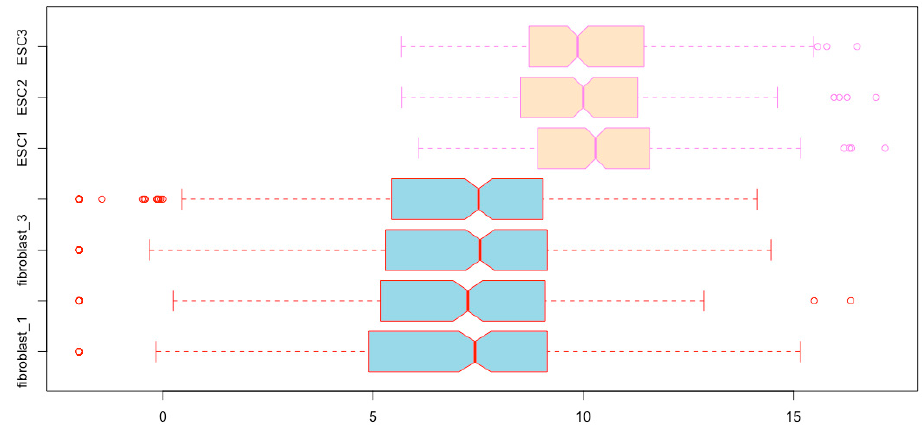
Figure 10. Place boxplots horizontally using the argument horizontal = TRUE or T .